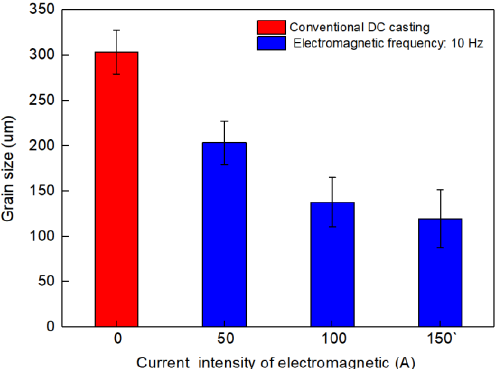
Figure 3. Average grain sizes of one-half radius region of cross section of ingots prepared in di ff erent electromagnetic conditions.